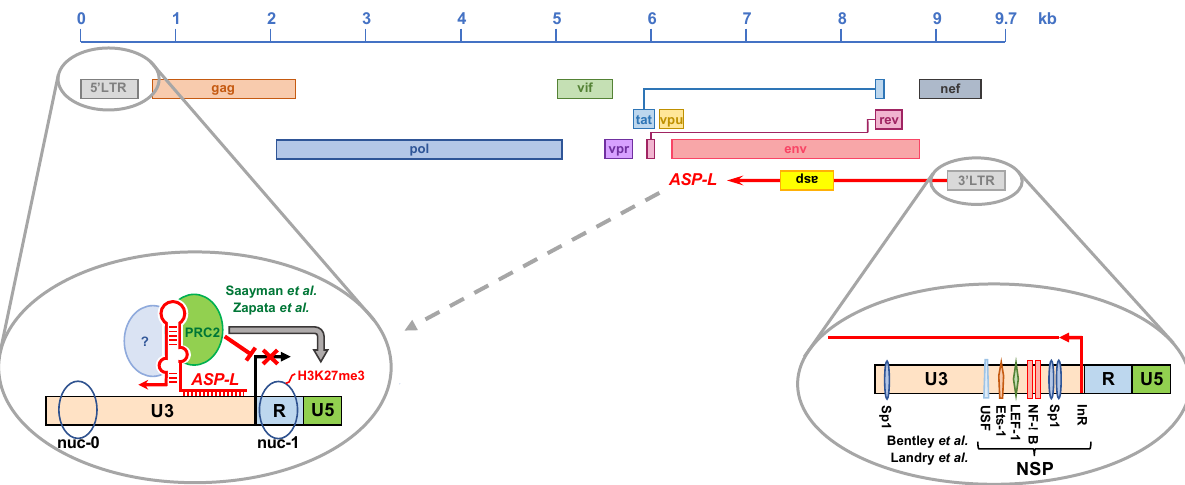
Figure 3. Role of HIV-1 NATs as inducers of proviral latency. Multiple reports have shown that HIV-1 NATs have a negative regulatory effect on the transcriptional activity of the HIV-1 5 ′LTR and contribute to the establishment and maintenance of HIV-1 latency. The suppressive activity of HIV-1 NATs has been shown to occur via epigenetic regulation of the 5′LTR, and it entails the recruitment of chromatin -modifying enzymes such as DNA methyltransferase 3a and the histone methyltransferase EZH2, which is a core component of polycomb repressor complex 2 (PRC2). All HIV-1 NATs originate in the U3 region of the 3′LTR, and thus share sequence identity with the U3 region of the 5′LTR. This allows NATs to interact with the 5′LTR via Watson– Crick and Hoogsteen base pairing.